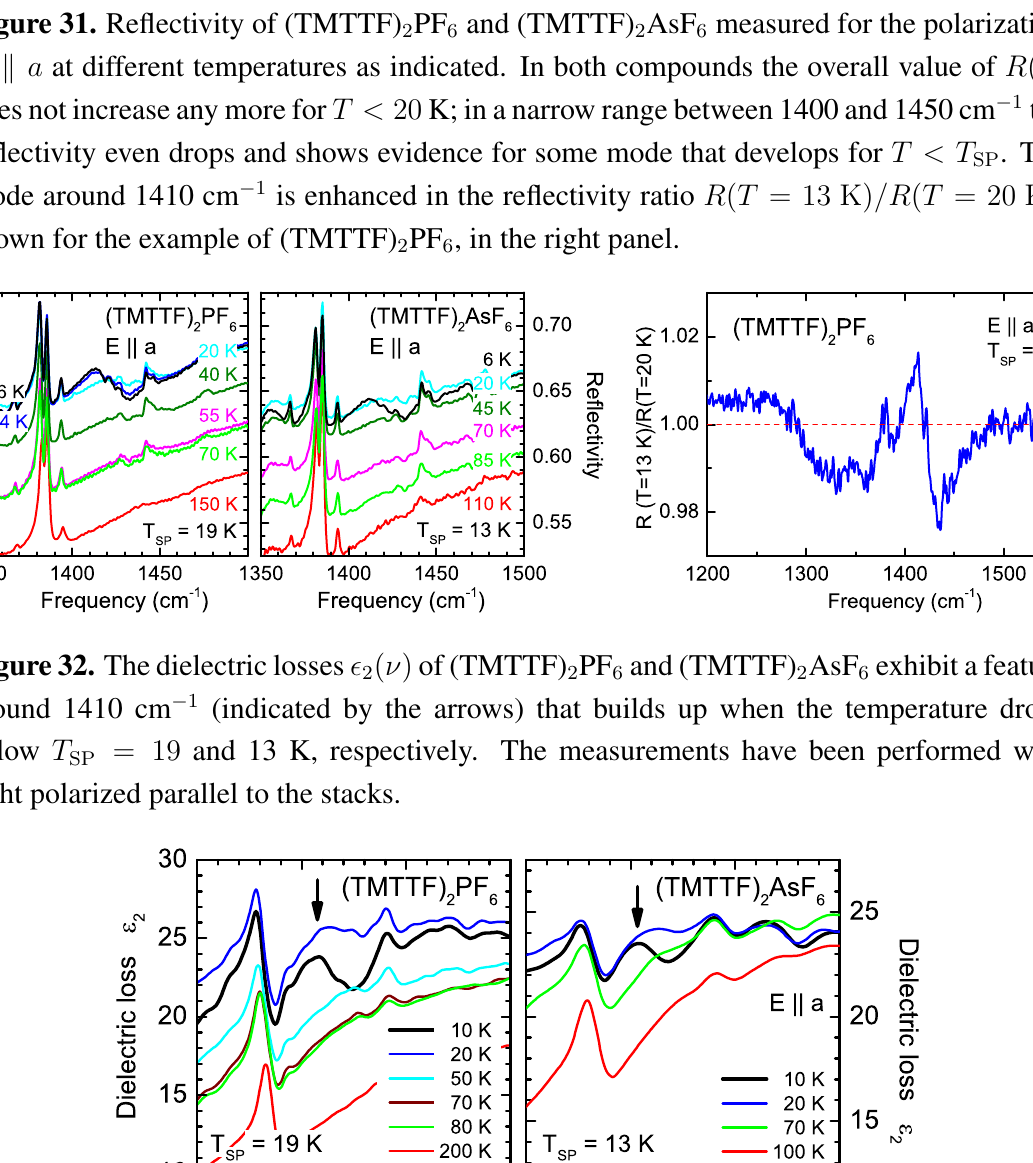
Figure 31. Reflectivity of (TMTTF) E (cid:107) a at different temperatures as indicated. In both compounds the overall value of R ( ν ) does not increase any more for T < 20 K; in a narrow range between 1400 and 1450 cm − 1 the reflectivity even drops and shows evidence for some mode that develops for T < T mode around 1410 cm − 1 is enhanced in the reflectivity ratio R ( T = 13 K) /R ( T = 20 K) , shown for the example of (TMTTF)